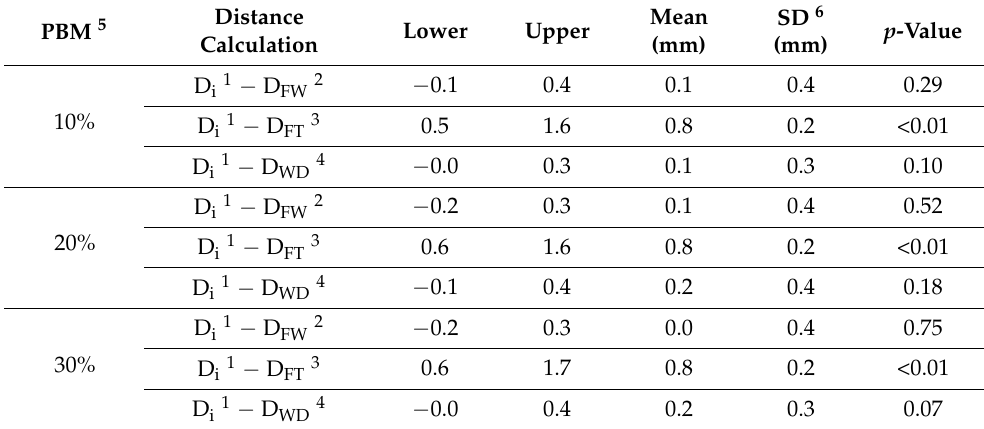
Table 1. Calculated differences in the distance measured for each load and each surgical